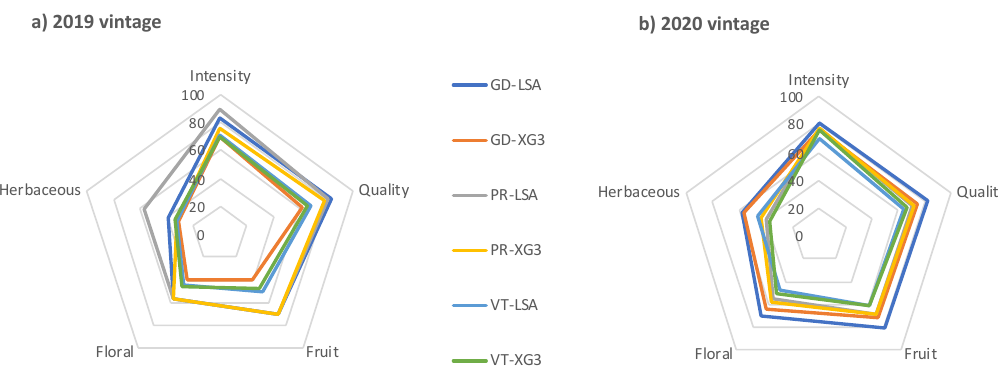
Figure 6. Aroma sensory analysis of Treixadura wines from Priorato de Razamonde (PR), O’Ventosela (VT) and Gandarela (GD) wineries obtained with different yeasts in 2019 ( a ) and 2020 ( b ) vintages.